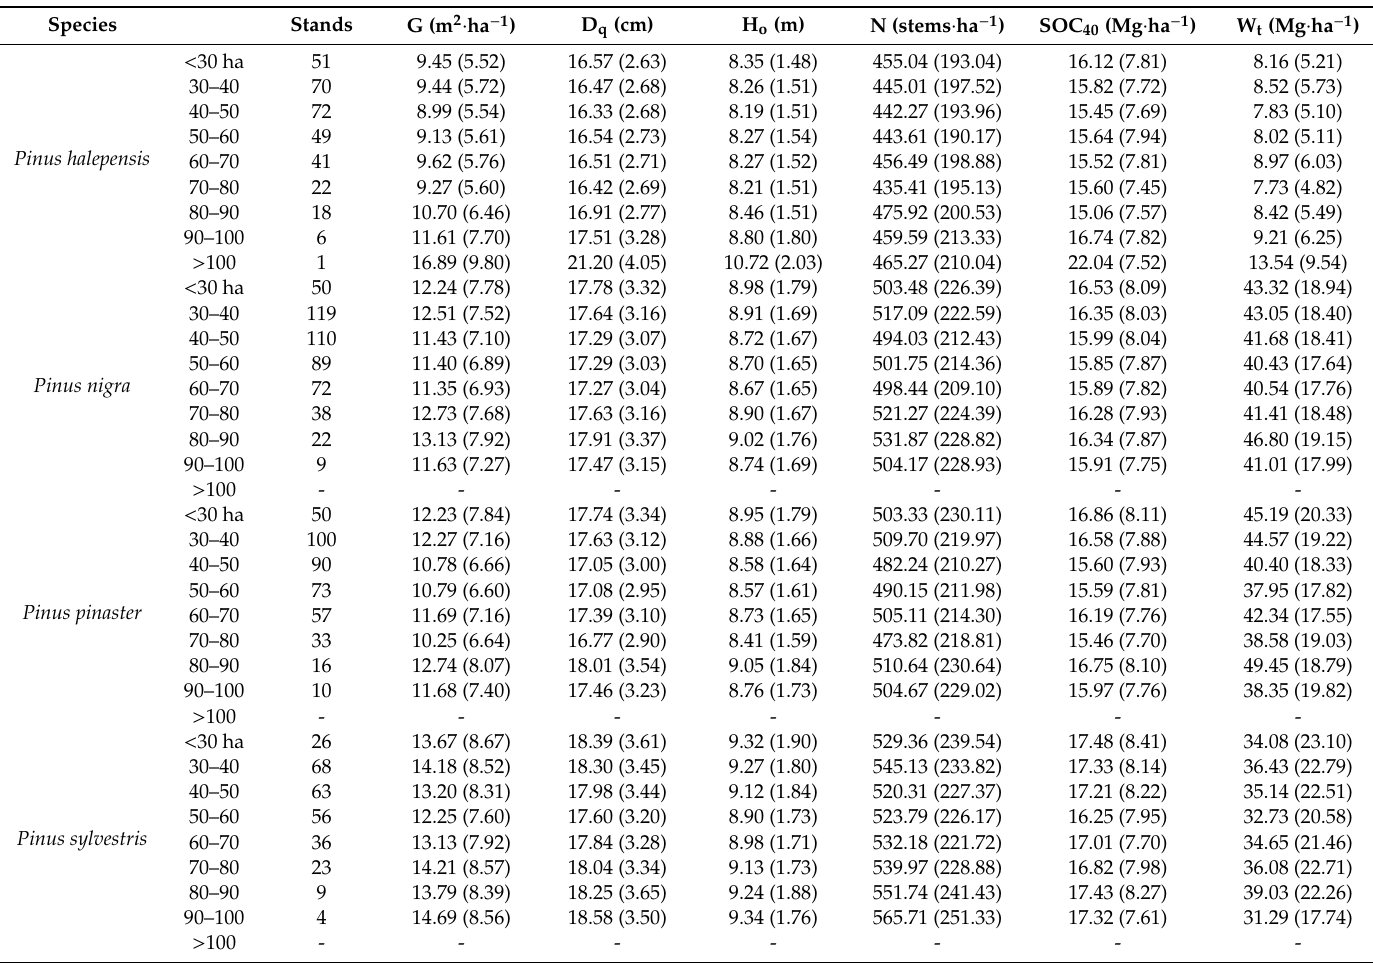
Table 2. Stand characteristics—basal area (BA), quadratic mean diameter (D q ), number of stems (N), dominant height (H o ), C stock in live-biomass (W t -S), and soil organic carbon stock in the 0–40 cm soil layer (SOC 40 )—for each of the four Pinus spp.: Pinus halepensis , Pinus nigra , Pinus pinaster , and Pinus sylvestris at Sierra de los Filabres (Southern Spain). Values are means